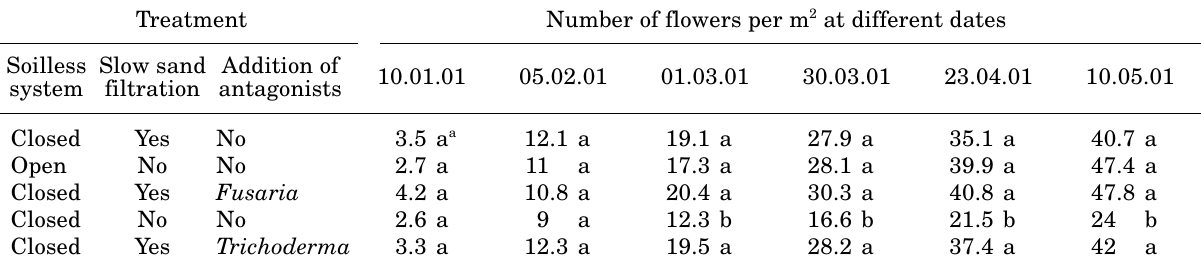
Table 8. The effect of selected strains of Fusarium and Trichoderma on the production of flowers per m 2 in gerbera plants grown in different closed soilless systems (Albenga,